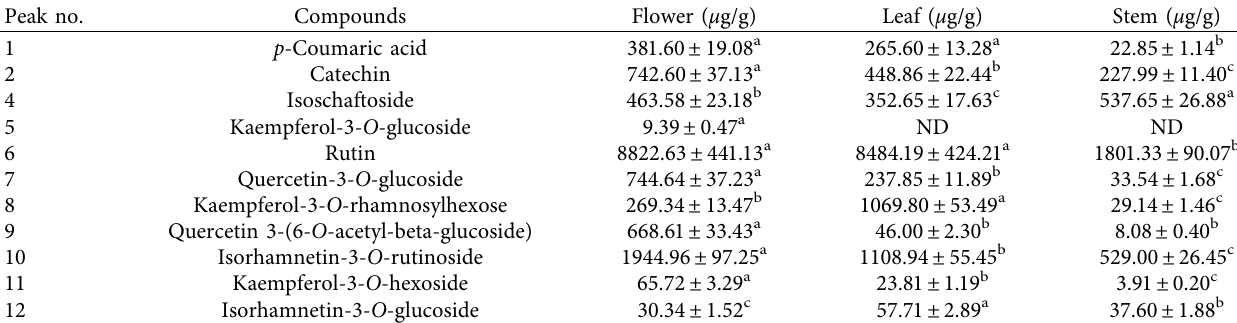
Table 3: Quantitation of phenolic substances in the flower, leaf, and stem of Prinsepia utilis Royle by UPLC-ESI-HRMS/MS. Peak